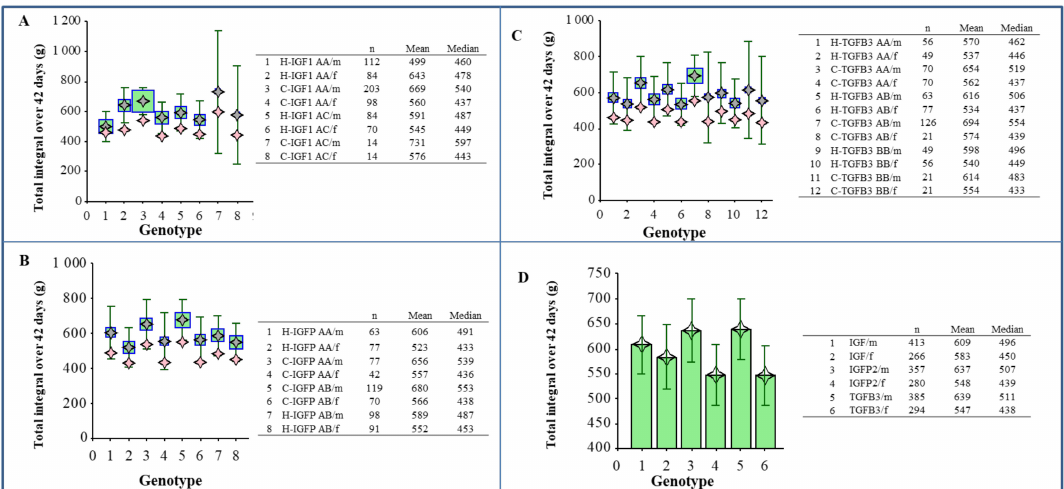
Figure 5. The weight sum of the trunk, giblets, abdominal fat, breast muscle with and without skin and thigh muscle with and without skin. IGF1 gene with genotype AA and AC ( A ), IGFBP2 with genotype AA and AB ( B ), TGF β 3 with genotype AA, AB and BB ( C ). The pink symbol—median, the grey symbol—mean, square indicates the weight (number of samples). A comparison of individual genotypes ( D ). Statistical characteristics of individual variants: number (n), mean and median. The line segments represent confidence interval–CI (95%); m—males,